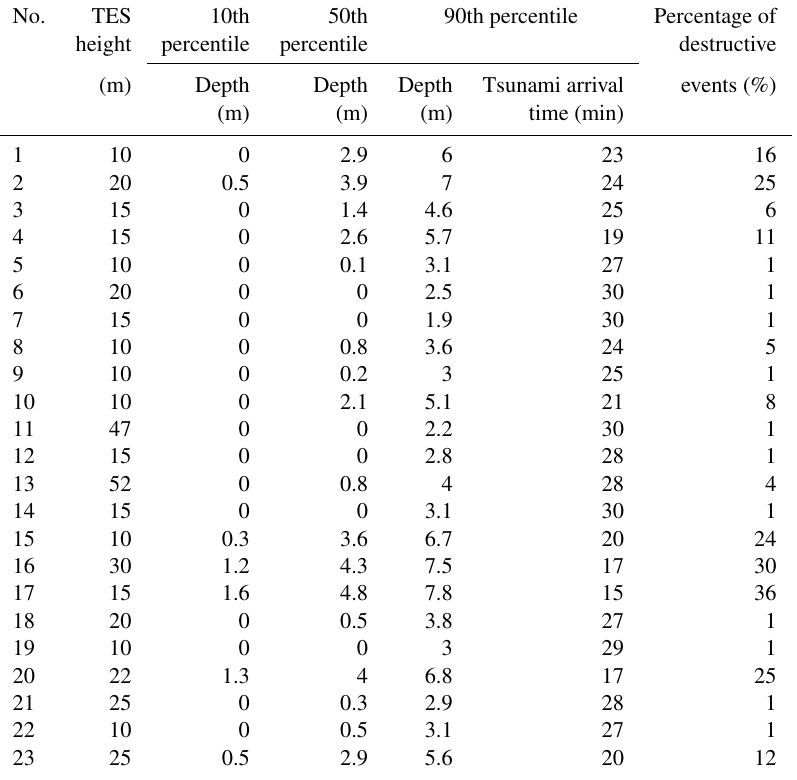
Table 5. Assessment of tsunami evacuation shelters (TES) in Padang in terms of depth, tsunami arrival time, and number of tsunami destruc- tive